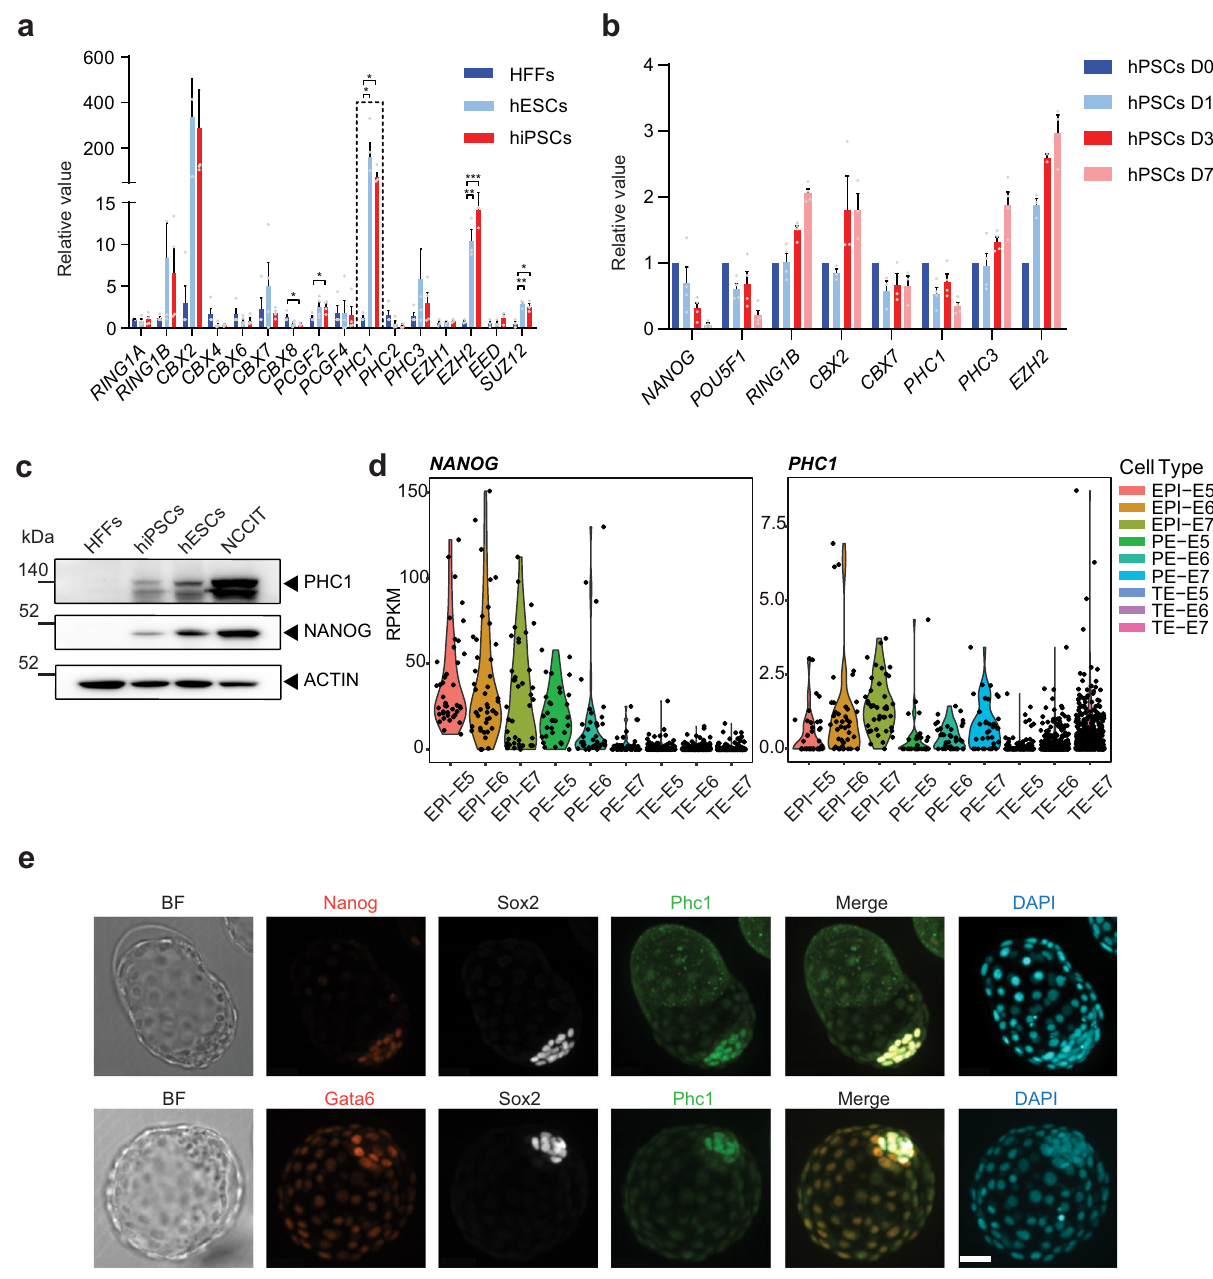
Fig. 1 PHC1 is highly expressed in both human and mouse pluripotent cells. a PRC1 and PRC2 gene expression was examined by RT-qPCR in HFFs, hESCs, and hiPSCs. ACTIN was used as the house keeping gene and expression was normalized to HFFs. n = 4 independent experiments for PRC1 genes; n = 3 independent experiments for PRC2 genes including EZH1 , EZH2 , EED , and SUZ12 . Error bars represent the s.e.m. Two-tailed unpaired t -tests were used ( p = 0.0256 for CBX8 , p = 0.0201 for PCGF2 , p = 0.0498 for PHC1 in HFFs vs. ESCs, p = 0.0104 for PHC1 in HFFs vs. iPSCs, ** p = 0.0022 for EZH2 , *** p = 0.0003 for EZH2 , ** p = 0.0034 for SUZ12 , * p = 0.0111 for SUZ12 ). b Expressions of PRC1 and PRC2 genes and key pluripotency factors POU5F1 and NANOG during embryoid body differentiation (D0 – D7) of hPSCs were examined by RT-qPCR. n = 3 independent experiments for CBX2, CBX7 , and EZH2 ; n = 4 independent experiments for the other genes. Error bars represent the s.e.m. c WB analysis of PHC1 and NANOG protein expression in hPSCs and HFFs. d Analysis of the published single-cell RNA-seq data of early human embryos (E5 – 7) showing expression of NANOG and PHC1 in epiblast (Epi), primitive endoderm (PE), and trophectoderm (TE) 32 . e Co-immunostaining of Phc1 with Nanog and Sox2, or Gata6 and Sox2 in mouse E4.5 embryos. Scale bars, 31 μ m. Source data are provided as a Source Data fi